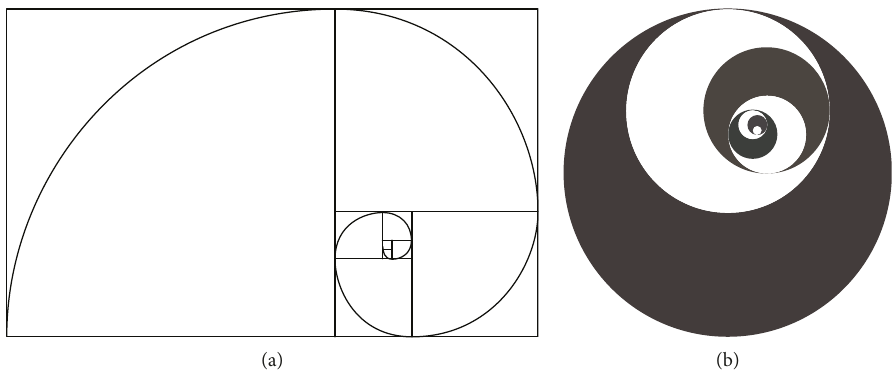
Figure 3: (a) Fibonacci spiral and (b) Fibonacci circles. Table 1: Fibonacci series related to fractal Fibonacci circles.